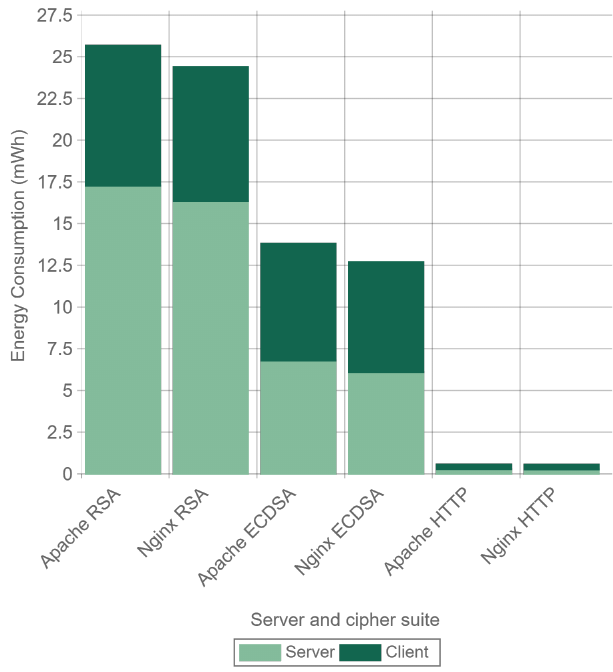
Figure 20. Total energy consumption for a 512-byte payload for 32 concurrent clients. Client and server-side consumption stacked for Apache and Nginx using Elliptic Curve Digital Signature Algorithm (ECDSA), Rivest–Shamir–Adleman (RSA), and plain